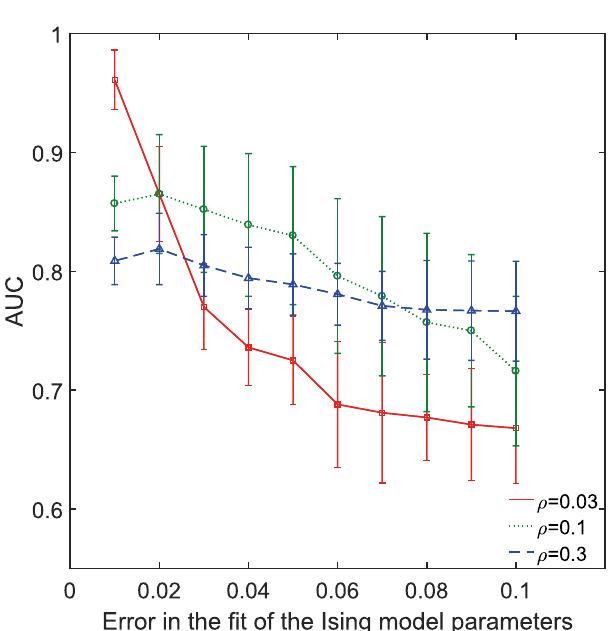
Figure 6. Effect of fit of the Ising model parameters on the inference of structural links. The error in the fit of the Ising model parameters is plotted against the AUC values obtained for the corresponding error levels for three mean network correlation levels ( ρ ) and a fixed firing rate for scale-free networks of 30 neurons. In all cases, lower the error in the fit of the Ising model parameters, higher was the detection of links in the structural connectivity